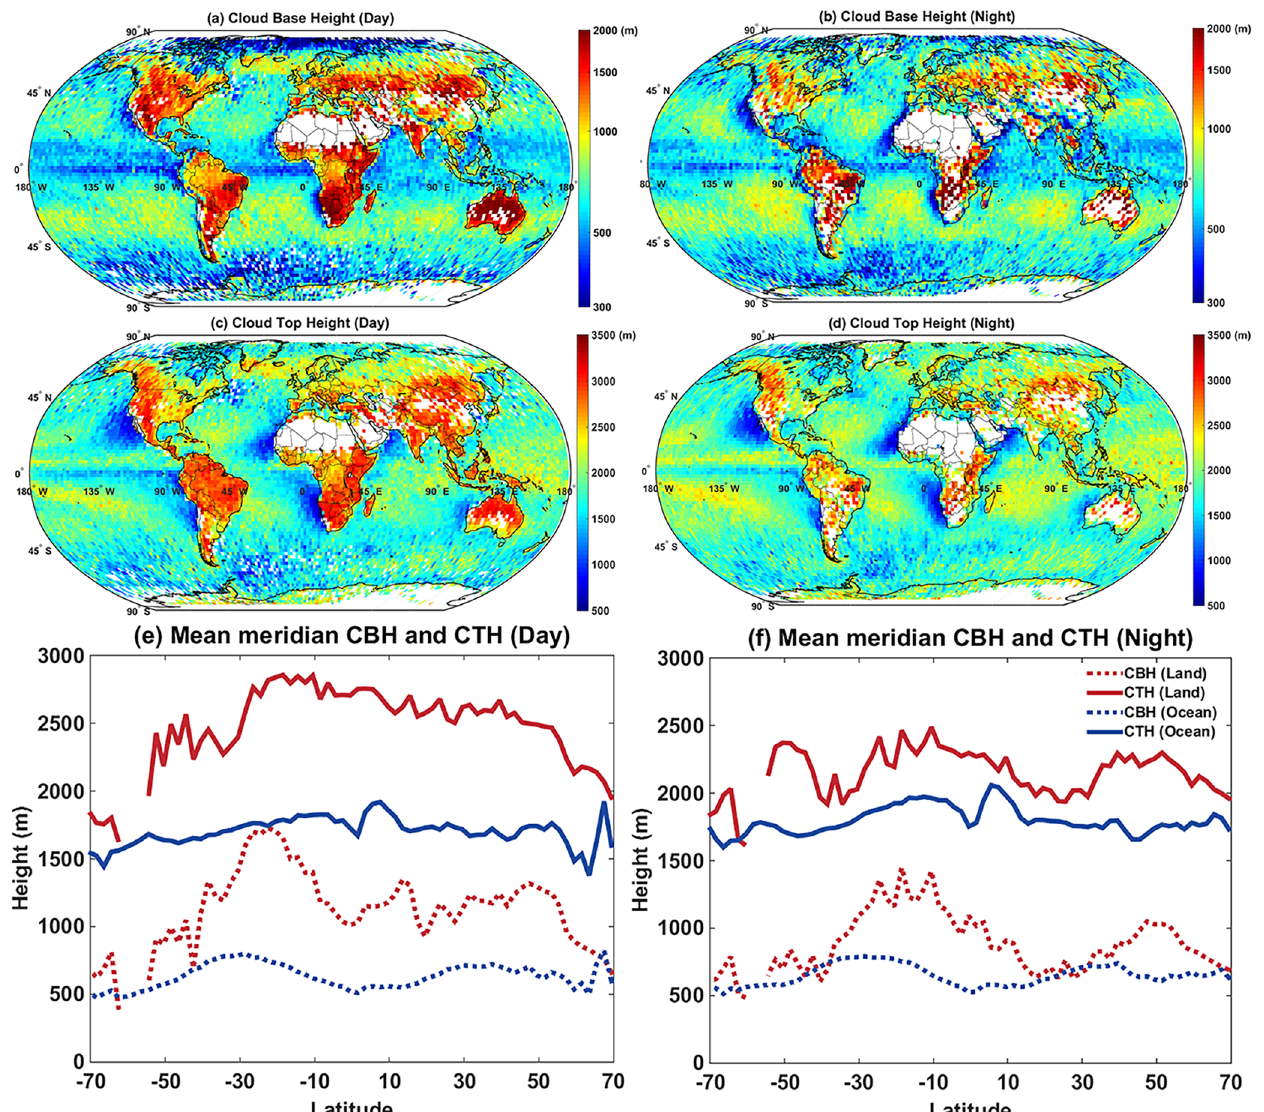
Figure 14. Geographic distributions of annual mean CBH on a 2 ◦ × 2 ◦ latitude–longitude grid in 2014 and 2017 for (a) CALIPSO daytime; panel (b) is the same as panel (a) but for nighttime; panel (c) is the same as panel (a) but for CTH; panel (d) is the same as panel (c) but for nighttime. The heights are in meters above ground level. Each grid has at least 10 valid scenes. (e) Mean meridian CBH and CTH over land and the ocean for CALIPSO daytime. Straight lines indicate CTH, and dotted lines indicate CBH (ocean in blue, land in red). Panel (f) is the same as panel (e) but for